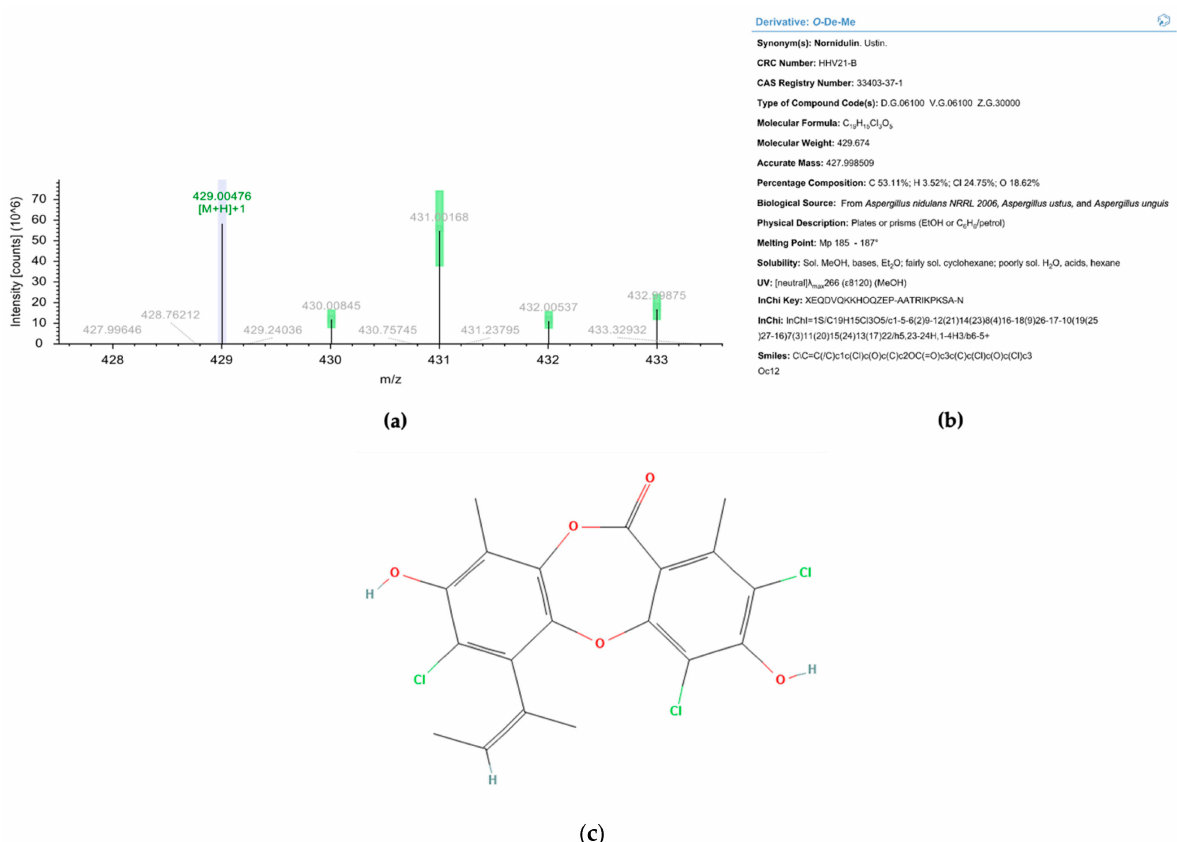
Figure 9. Liquid chromatography-mass spectrometry analysis of Fr10. ( a ) Electropherogram of Fr10 taken at positive mode. ( b ) Identification result of Fr10 from Dictionary of Natural Product database, based on UV spectrum and MS data. ( c ) Molecular structure of nornidulin (Pubchem ID